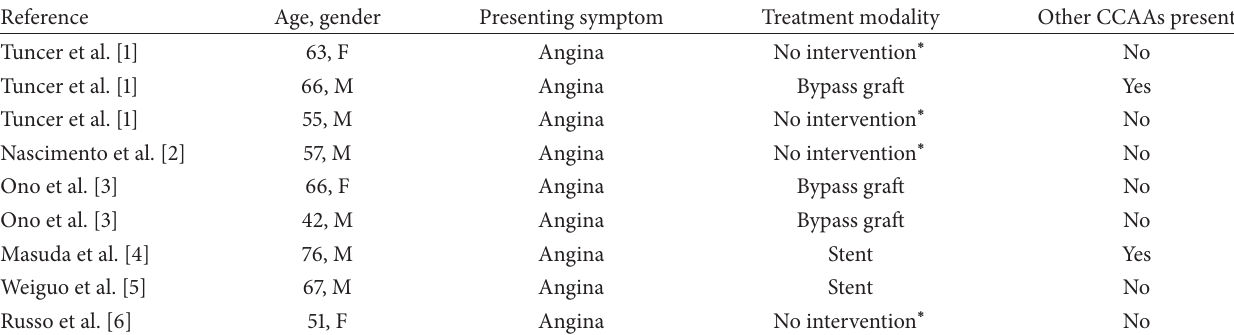
Table 1: Past cases of single anomalous LAD artery originating from the